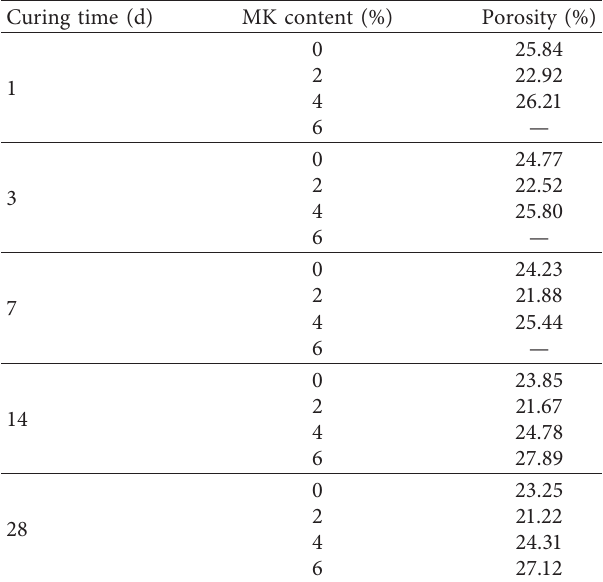
Figure 5: Test results between E 50 and UCS of MK-cemented silty clay. Table 3: Porosity results of MK-cemented silty clay.